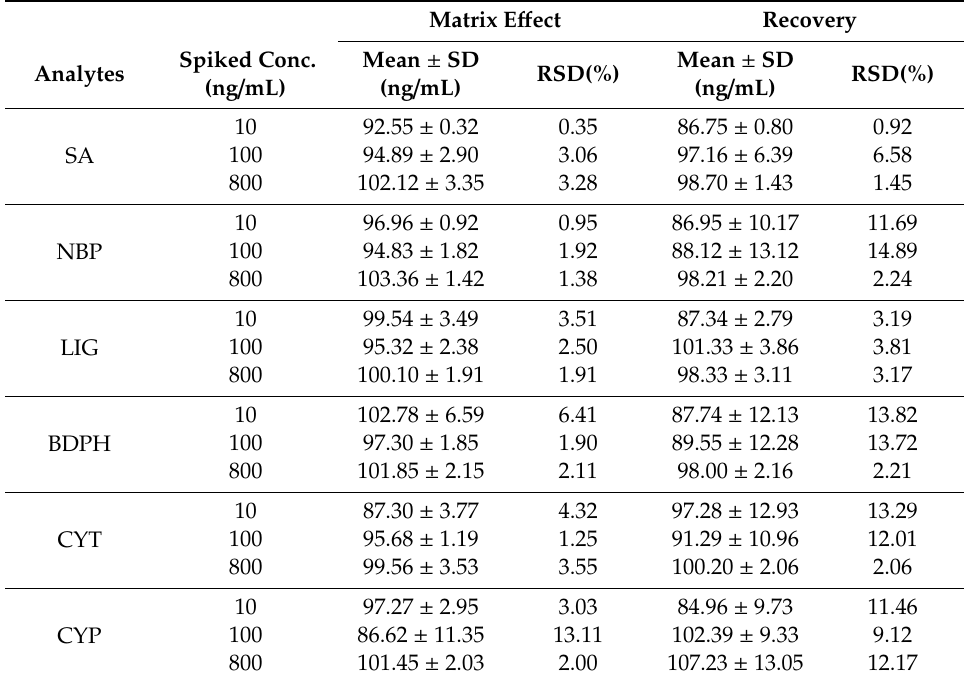
Table 4. Matrix e ff ects and recoveries of the analytes in rat cerebral cortex homogenate ( n =